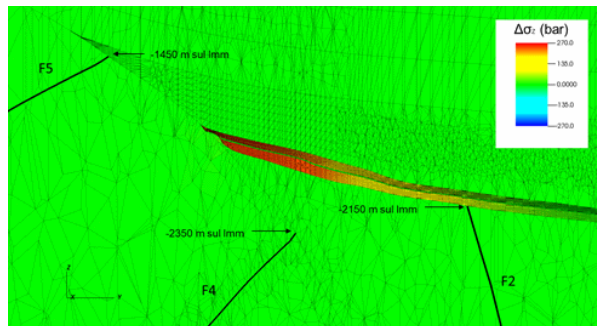
Figure 5. Distribution of the vertical stress variation during stor- age with p = 180% p i in a vertical cross section of the 3D mesh through the pools of the Romagna